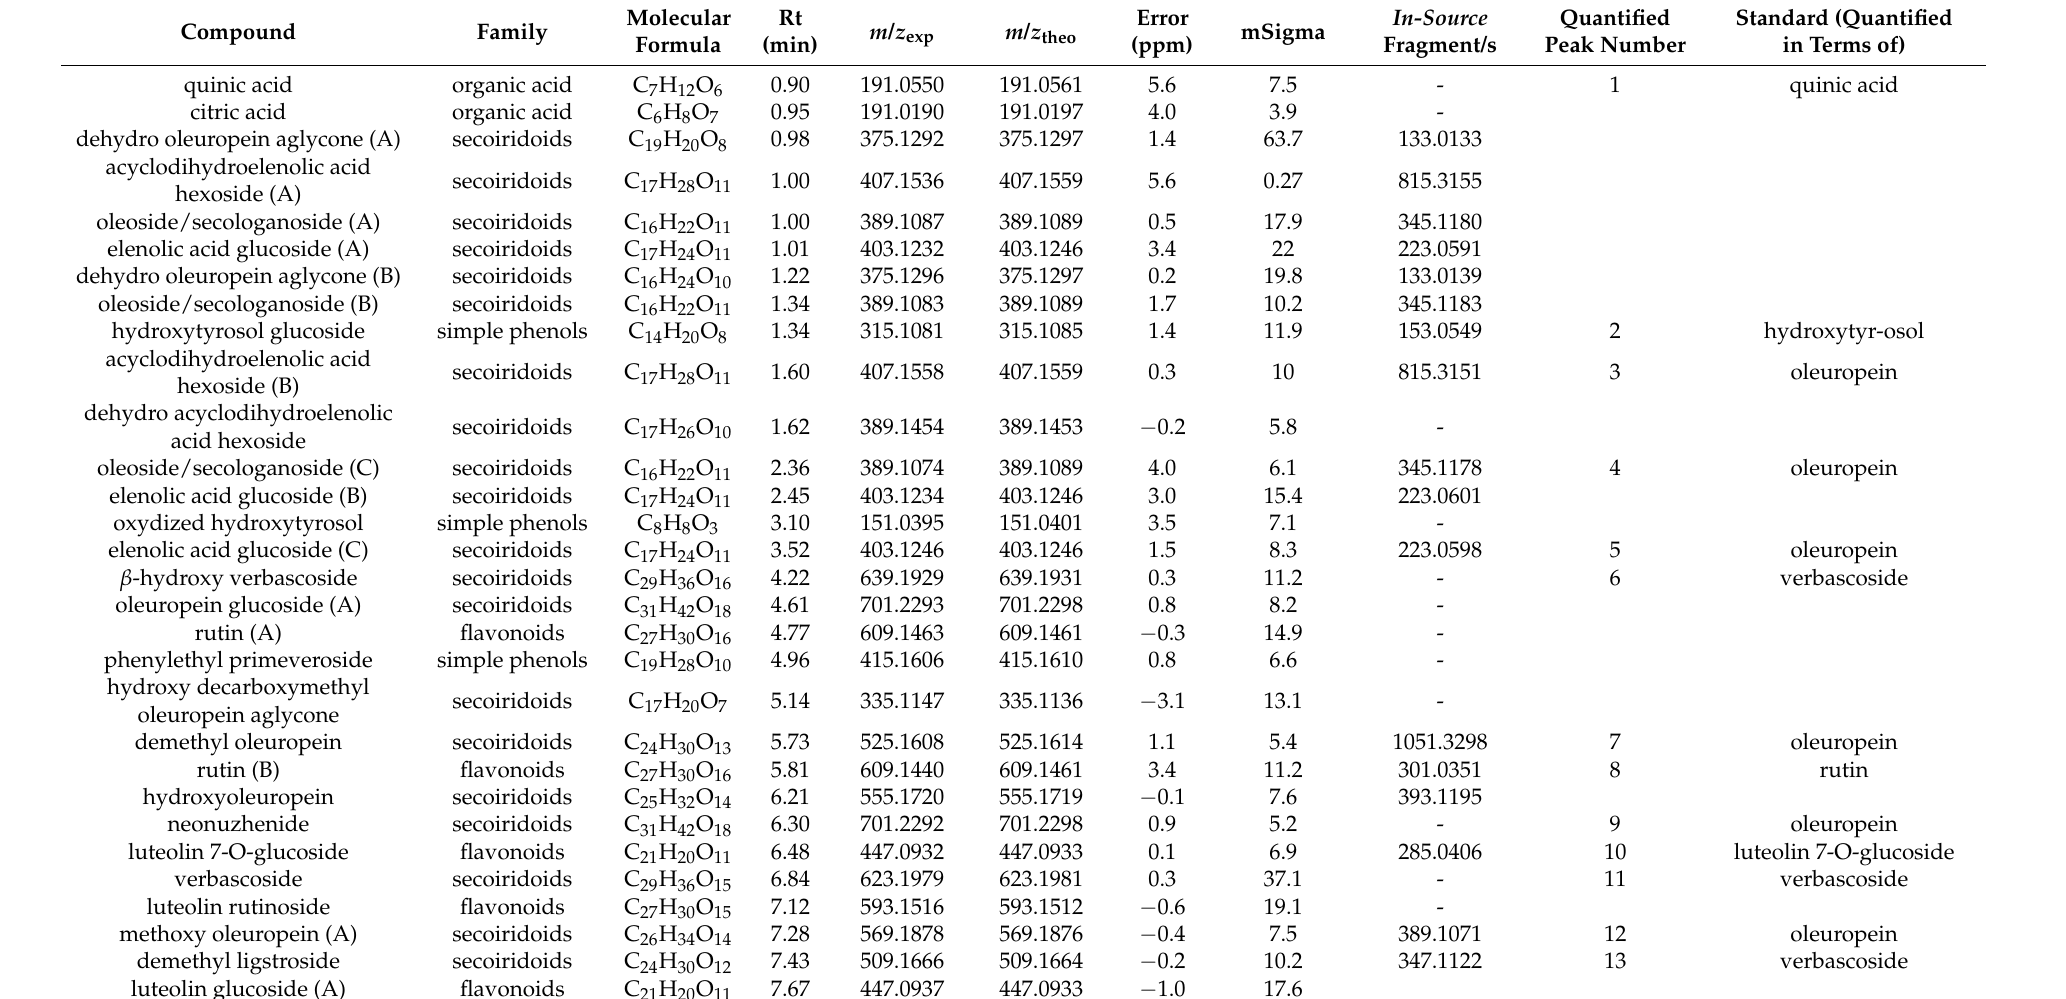
Table 2. First qualitative exploration of progenies from Olea europaea subsp. cuspidata